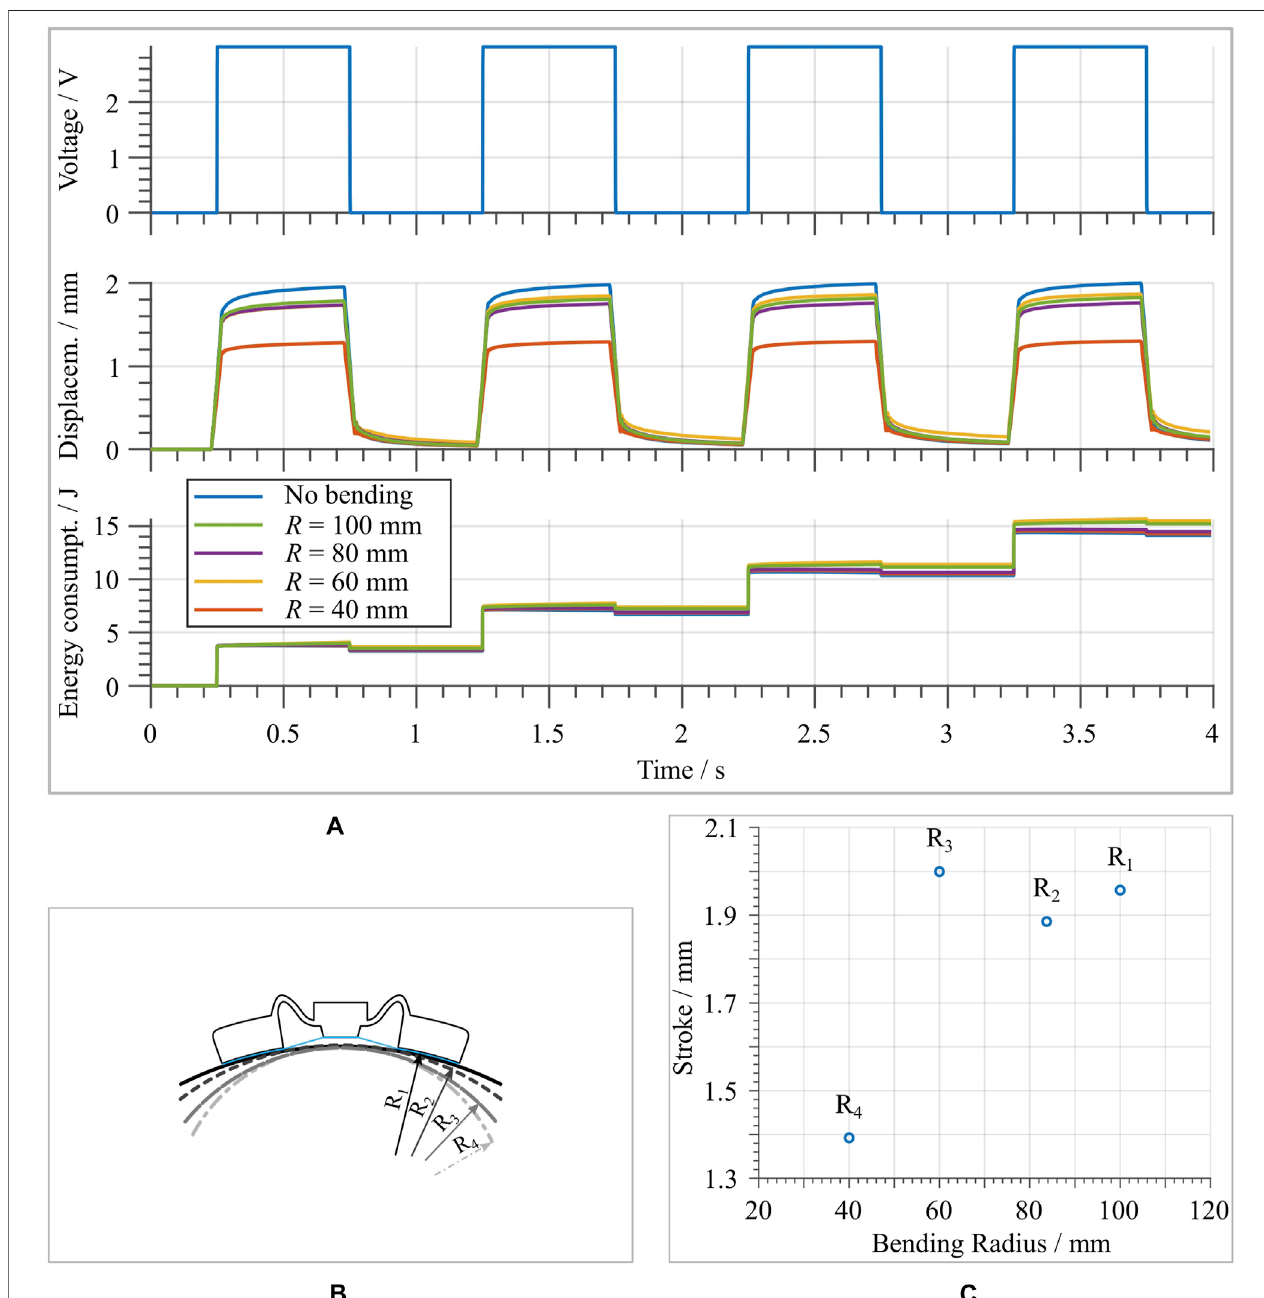
FIGURE 14 | (A) Stroke and energy consumption measurement of the actuator in different deformed con fi gurations, together with the results in the undeformed state as reference. (B) Cross-sectional schematic of the applied deformation. Note that the deformation corresponds to a cylindrical, rather than spherical, shape. (C) shows the maximum stroke as a function of the curvature